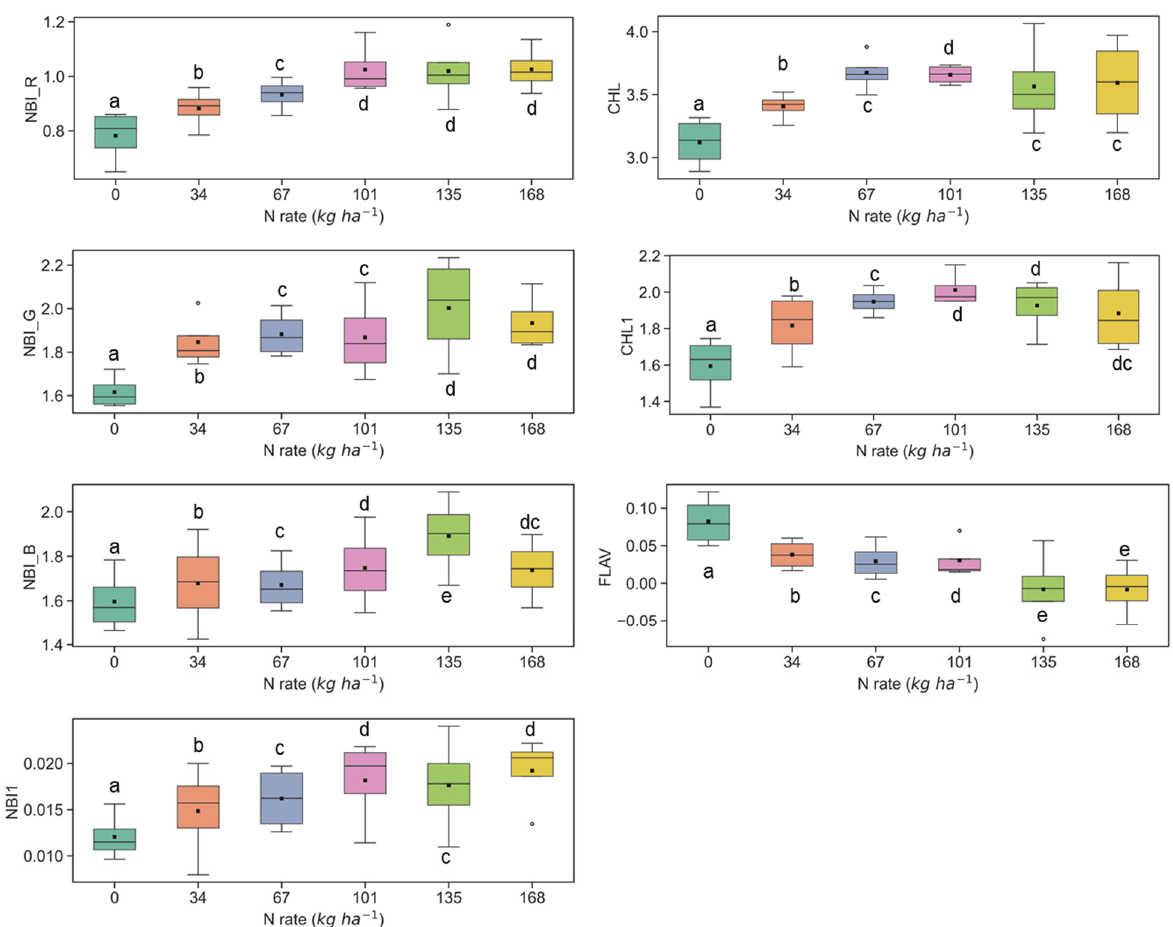
Figure 6. Response of Multiplex fluorescence indices over maize canopy treated with different N application rates at the V9 growth stage at the Iliff site. Different letters (a, b, c, d, e) indicate significant differences according to the Tukey’s HSD test at p < 0.05 significance level.